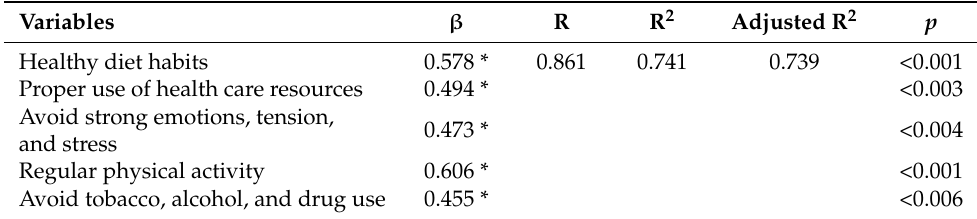
Table 10. Multiple linear regression analysis of